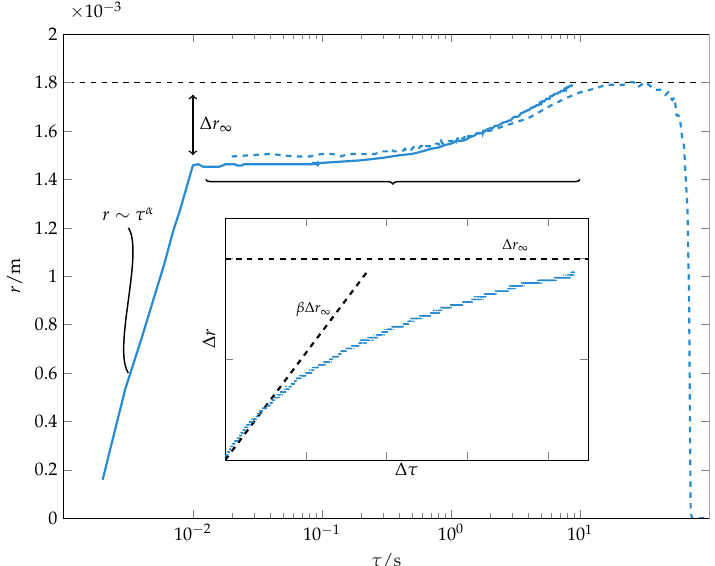
Figure 3. Wetting radius over time for a whole droplet life course. Two separate recordings (1ms resolution, solid line and 20ms resolution, dashed line) are shown within the same plot. The sudden change in wetting speed at τ 10ms marks the end of the initial wetting phase. The insert magnifies ≈ the wetting process for τ > τ init in linear representation. The parameter ∆ r ∞ (see Equation (3)) and the initial wetting speed β ∆ r ∞ are given as dashed lines for toluene drops on PS ( M W = 320kgmol − 1 ).